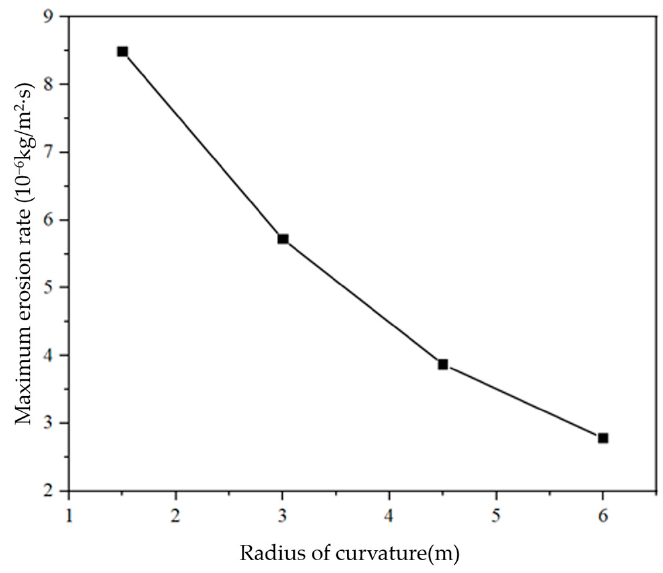
Figure 10. The relationship between the maximum erosion rate and the radius of curvature.